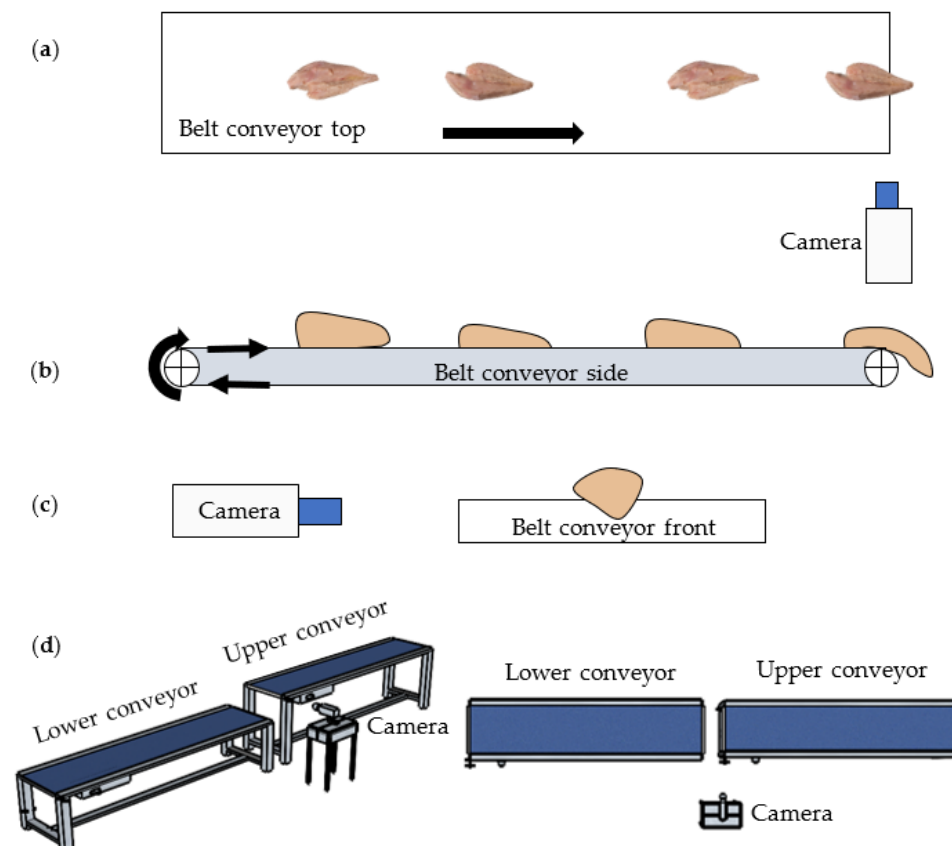
Figure 1. Schematics of the system setup viewed from ( a ) the top, ( b ) side, and ( c ) front; ( d ) schematics of the system with up- and downstream conveyors.